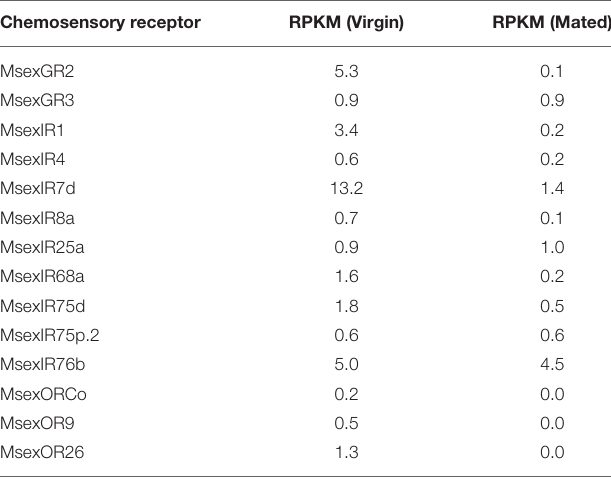
TABLE 1 | Expression values of chemosensory receptor genes in M. sexta ovipositor tissue. Chemosensory receptor RPKM